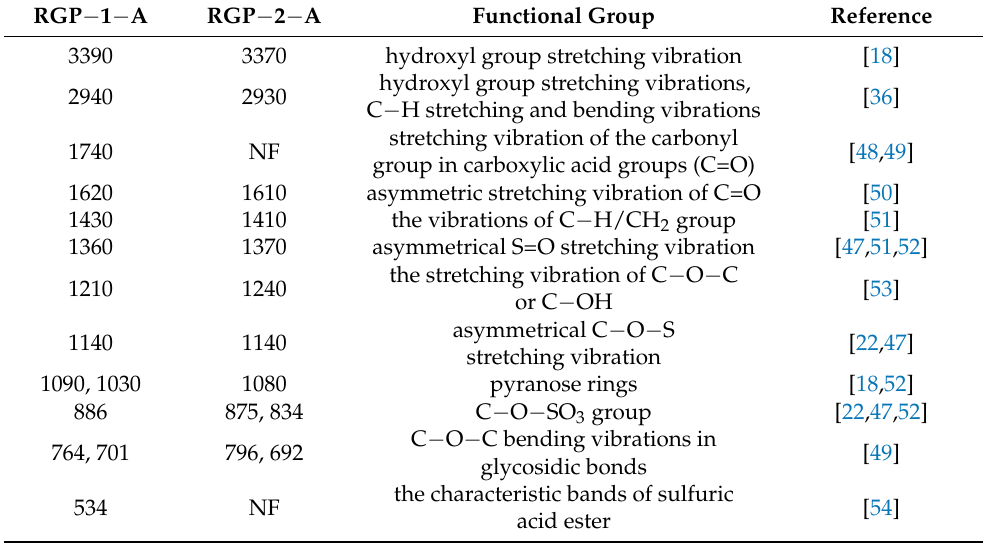
Figure 2. FTIR patterns of RGP − 1 − A and RGP − 2 − A. RGP − 1 − A: Rehmannia glutinosa polysaccharides decolorized by the AB-8 macroporous resin; RGP − 2 − A: Rehmannia glutinosa polysaccharides decolorized by H 2 O 2 . Table 4. List of polysaccharide-specific FTIR vibrational